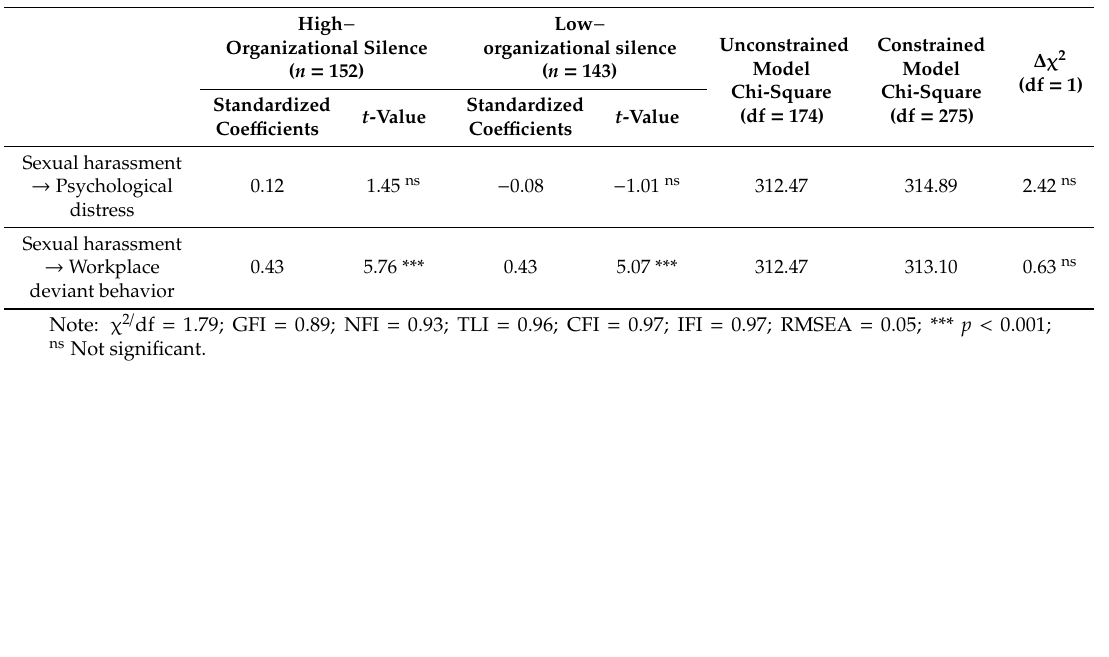
Table 4. Moderating e ff ects of organizational